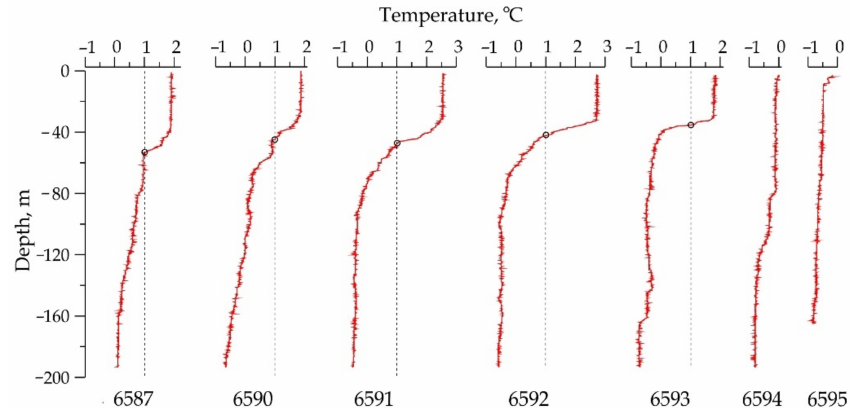
Figure 2. Water temperature profiles at the stations (6587–6595) along the transect in the Bransfield Strait. The depths of 1 ◦ C isotherm (marked with empty circles) corresponded to the front between TBW and